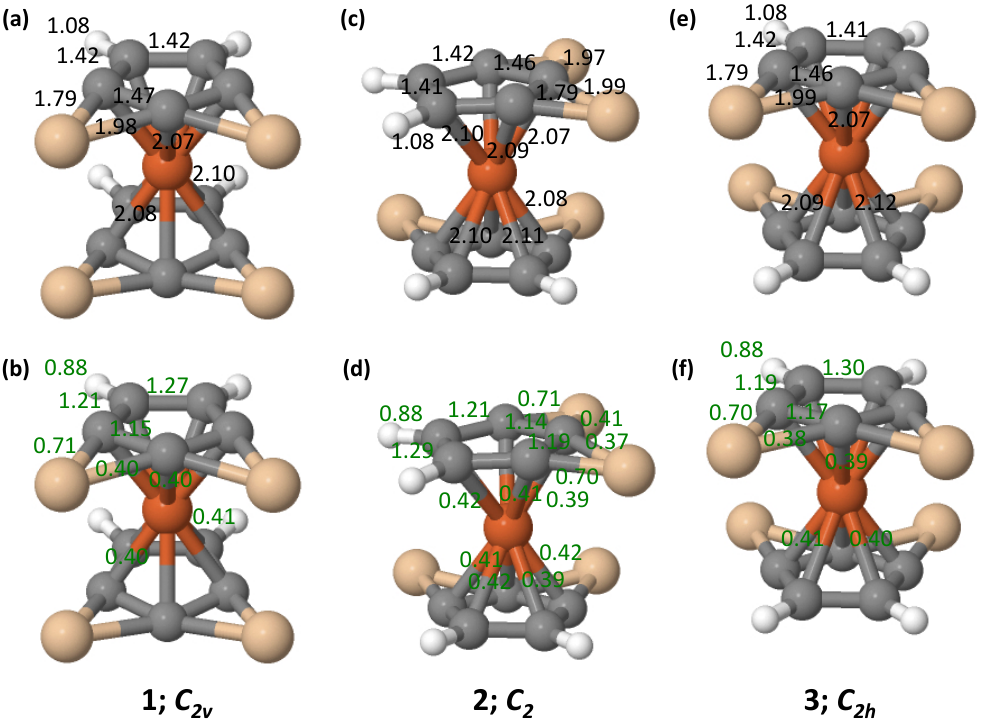
Figure 1. Optimized singlet electronic state structures of ( a ) eclipsed-, ( 1 A staggered-[Fe(Si 2 - η 5 -C 5 H 2 ) 2 ] 2 + ( 1 A g ) (Fe:orange; Si:bisque; C:gray; H:white) obtained at the ω B97X- D/def2-TZVP level of theory. Bond lengths are indicated in Å. Wiberg bond indices (in green) calculated at the same level are given in ( b ), ( d ), and ( f ),